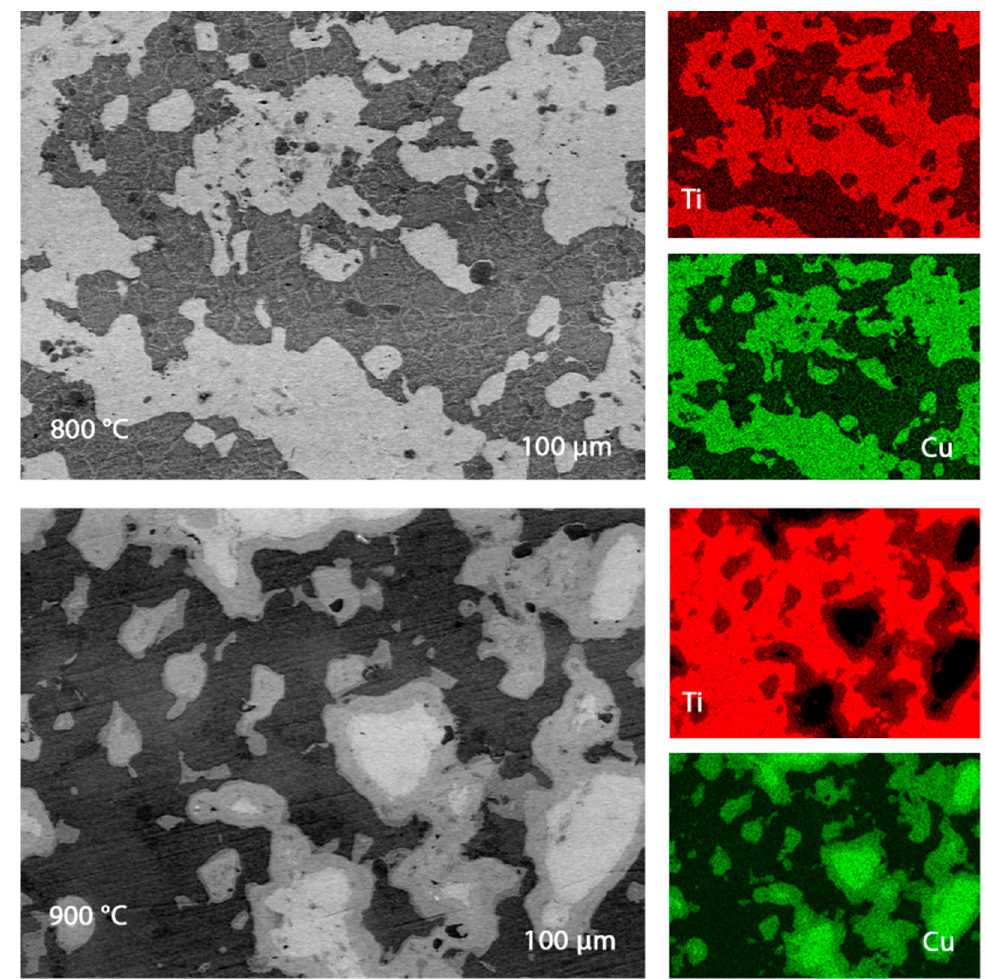
Figure 5. Electronic images of the sample plane, titanium, and copper content.